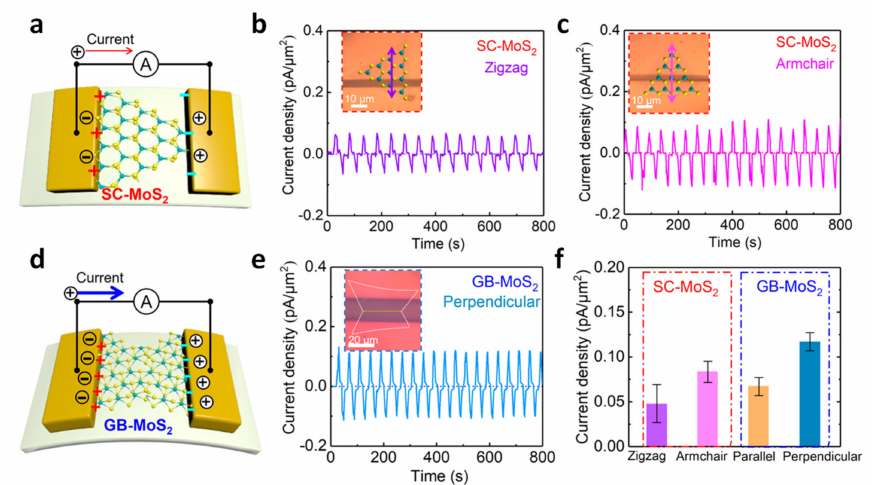
Figure 8. ( a ) Illustration of the SC-MoS 2 flake-based flexible piezoelectric device. The real-time current output of SC-MoS 2 piezoelectric devices along ( b ) zigzag and ( c ) armchair orientations. ( d ) Illustration of a GB-MoS 2 flake–based flexible piezoelectric device. ( e ) Current output obtained from the GB-MoS 2 piezoelectric device perpendicular to the grain boundary direction. ( f ) Current densities of MoS 2 -based piezoelectric devices under various conditions under the same experimental conditions. Reproduced with permission from [72], Copyright 2020, American Chemical